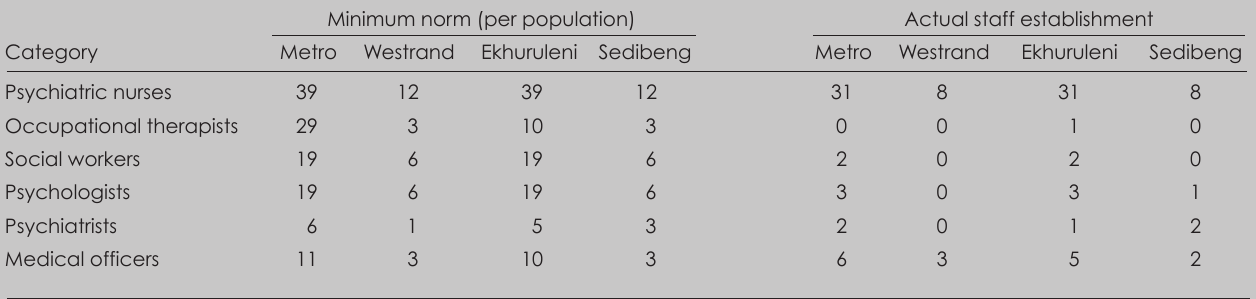
Districts Metro Westrand Ekhuruleni Sedibeng